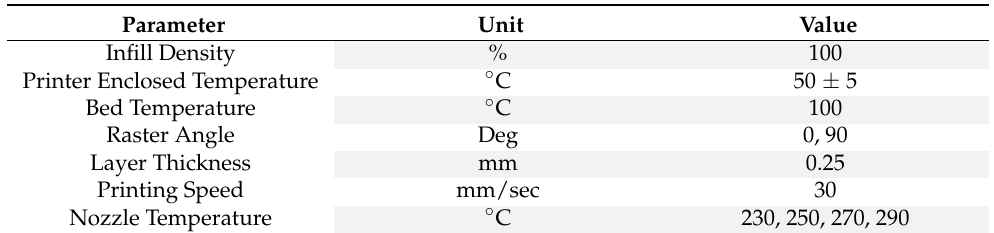
Table 1. Material processing parameters.